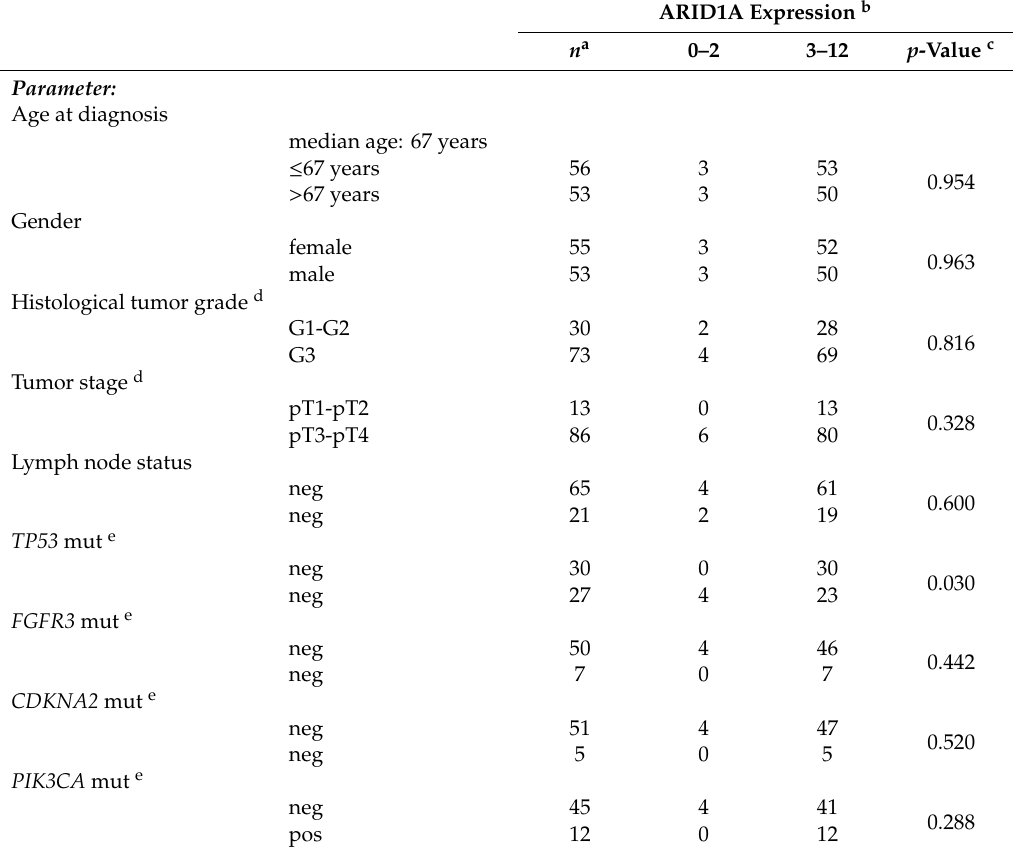
Table 3. Clinico-pathological parameters and known driver mutations in relation to ARID1A expression loss.